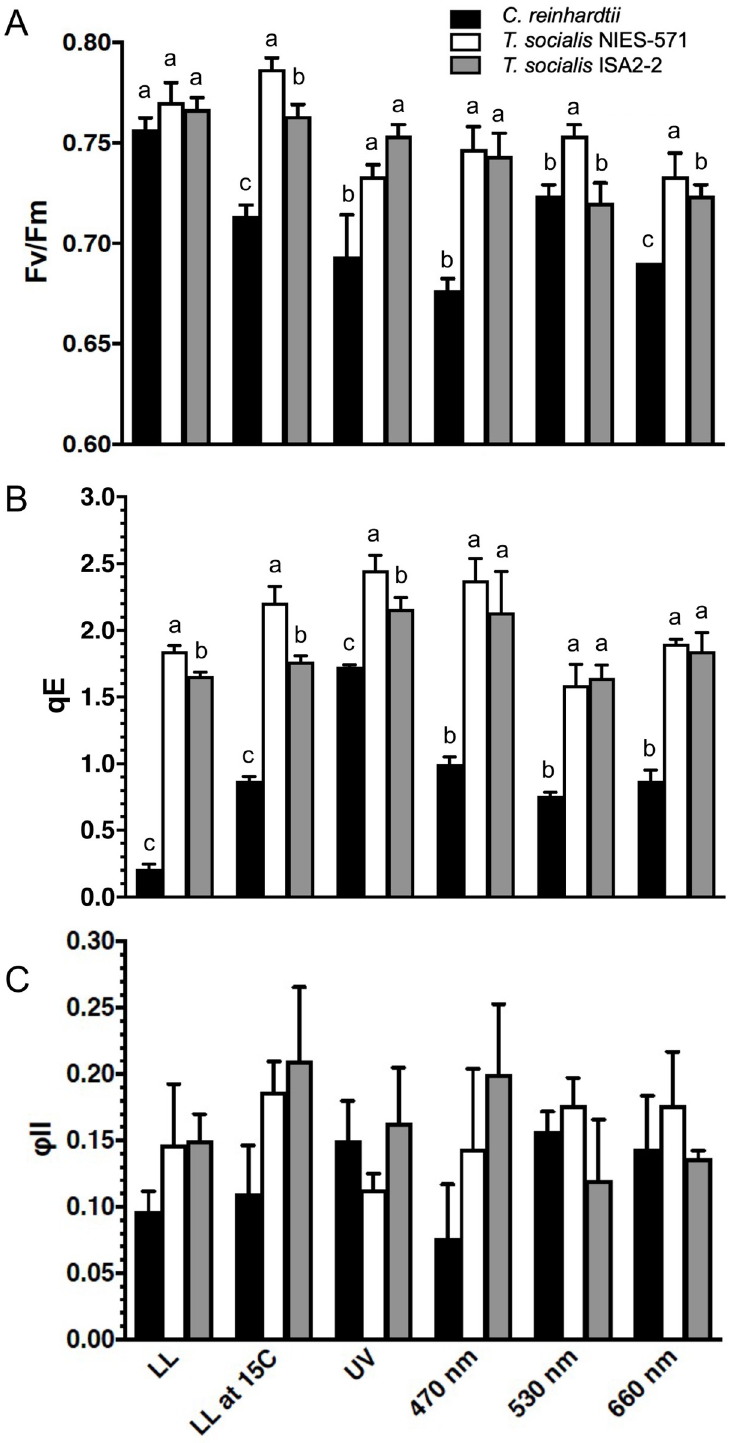
Fig 6. Photosynthetic parameters of C . reinhardtii and T . socialis under various light conditions . Fv/Fm (A), NPQ (qE) (B), and φ II (C) of wild-type C . reinhardtii and T . socialis NIES-571 and ISA2-2 strains were measured by a pulse- amplitude modulation chlorophyll fluorometer. Cells/colonies were illuminated under various light conditions (LL: white fluorescent light at 20 μ mol photons m − 2 s − 1 ; UV fluorescent light at 20 μ mol photons m − 2 s − 1 ; 470-, 530-,